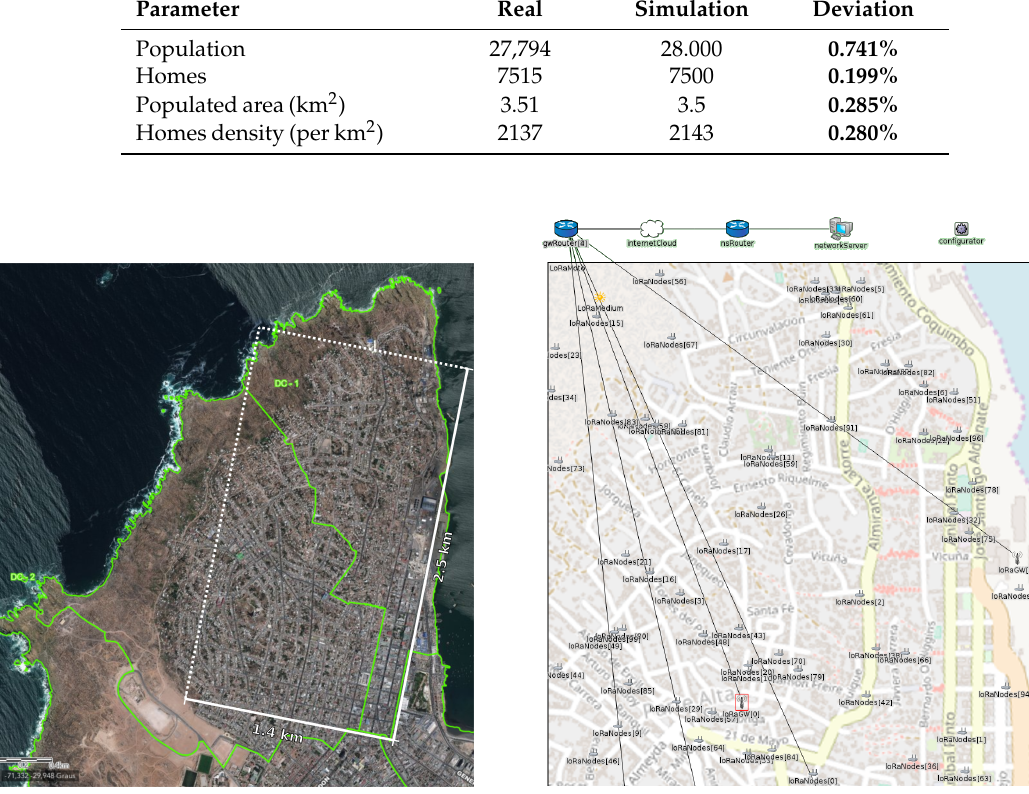
Figure 2. left : the rectangular area of 1.4 km × 2.5 km layered on top of the Coquimbo Peninsula with lDC-1 and DC-2 depicted. right : screen capture of the OMNeT++ running the FLoRa framework, layered over the Coquimbo Peninsula showing the user nodes and gateways, and the remaining components on